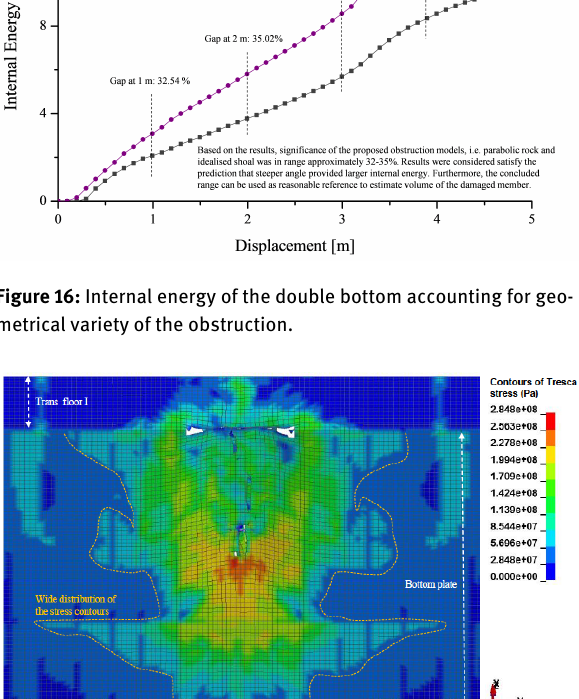
Figure 17: Damage-stress contours on the double bottom during impacted by the polynomial rock. Based on this illustration, wide contours occurred on large part of the ship breadth.